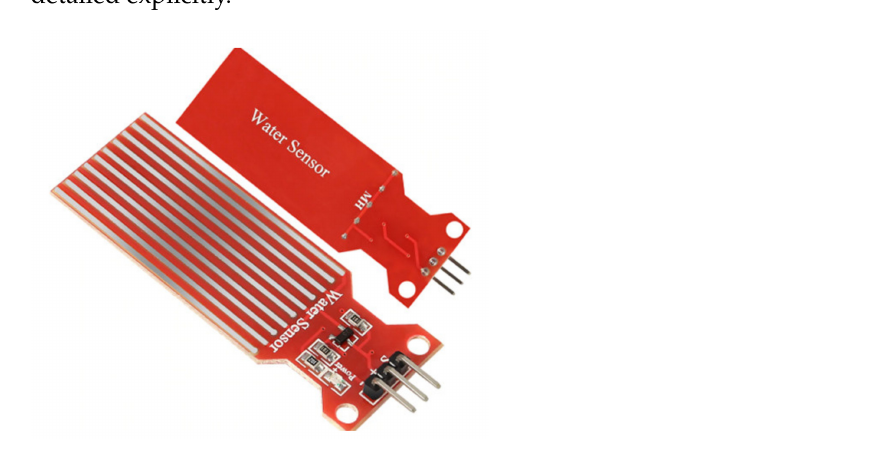
Figure 4. Water sensor used in [93], Courtesy of the Shenzhen Ke Zhi You Technology Co., Ltd.,